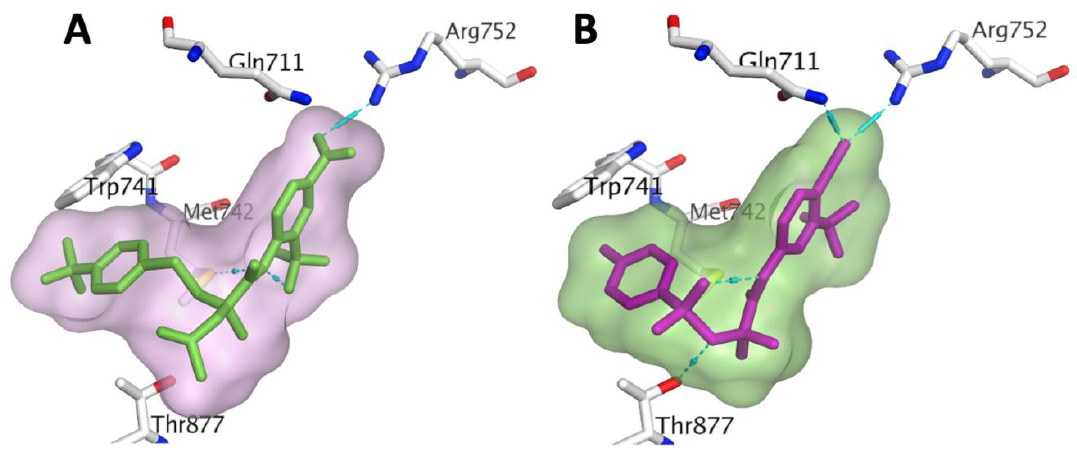
Figure 5. The predicted binding mode of compound 27 ( A ) and bicalutamide ( B ) inside the hAR-LBD showing H-bond interactions (turquoise dashed line) with key amino acids, Arg 752, Gln 711, Met 742, and Thr 877.